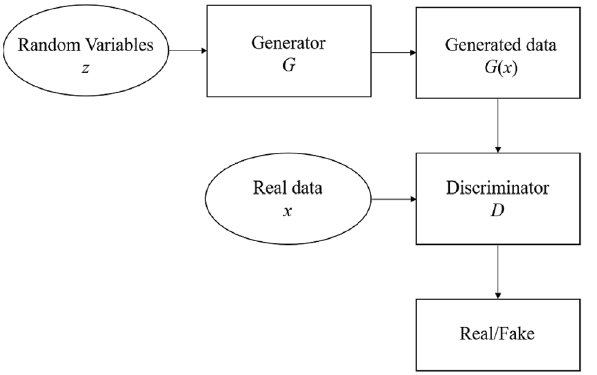
Figure 2. Calculation process of